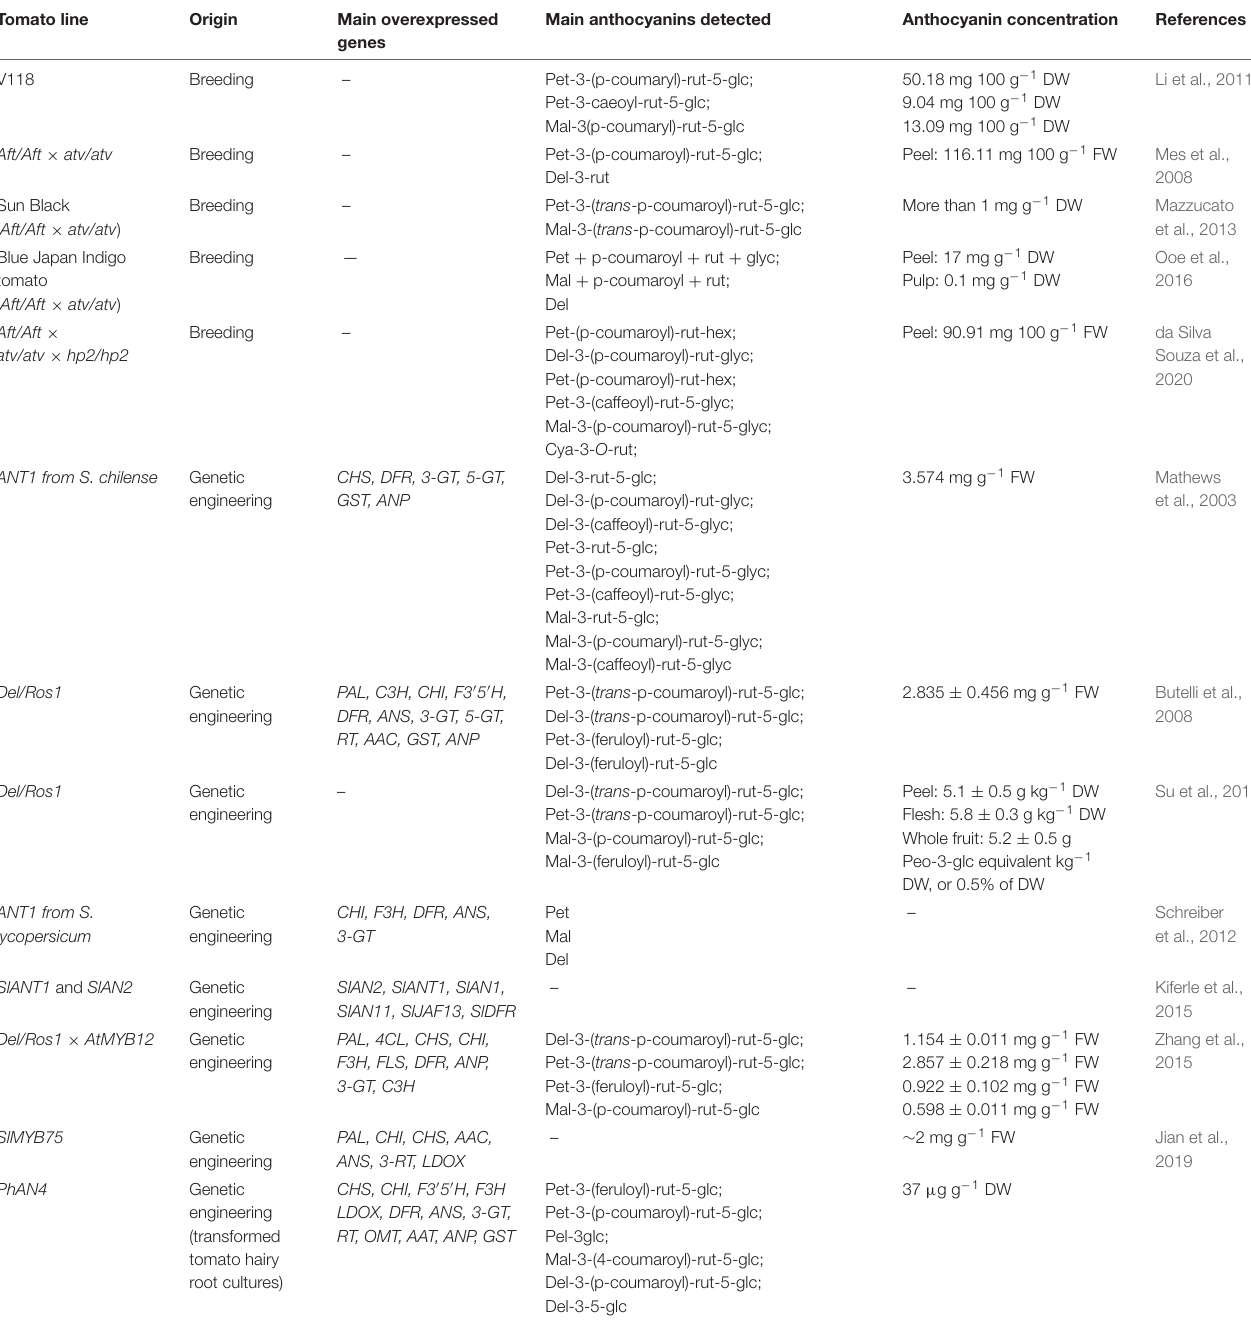
TABLE 2 | Summary of results from the main research on tomato plants enrichment with anthocyanins obtained by both conventional breeding and genetic engineering approaches. Tomato